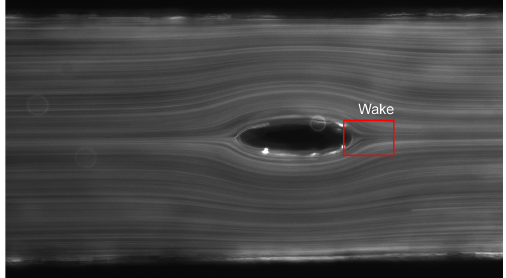
Figure 4. Example of the formation of a wake in a Newtonian fluid around an ellipsoid. The flow direction is from left to